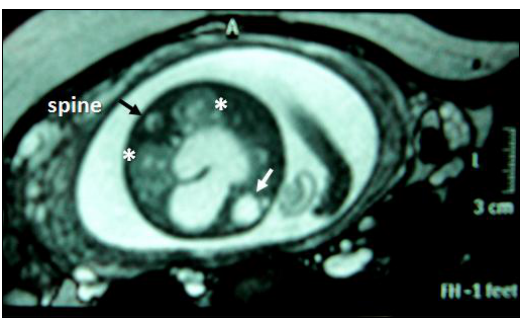
Figure 4: Fetal MRI axial plane.